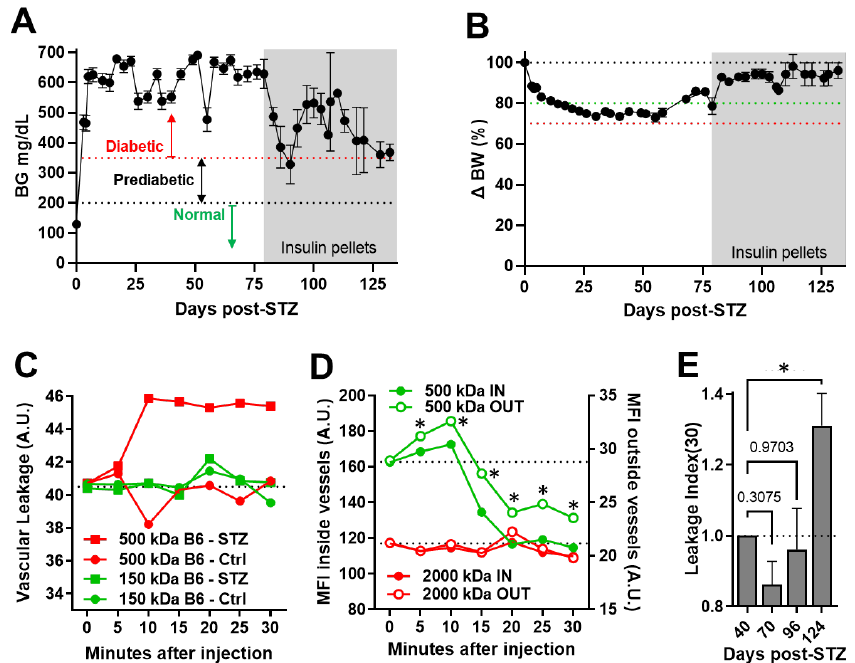
Figure 2. Longitudinal in vivo quantitation of retinal vascular leakage during the progression of induced DR in diabetic C57BL/6 mice. ( A ) Blood glucose levels in streptozotocin (STZ)-induced diabetic C57BL/6 mice showing chronic severe hyperglycemia, which leads to diabetic retinopathy (DR) in 4 months following diabetes induction. ( B ) Body weight changes (expressed as % delta; Δ) following diabetes induction before and during insulin therapy by slow-release insulin pellets (Linplant; LinShin Canada Inc; Toronto, Canada). Data are shown as means ± SEM (n = 3–15 mice). The animal numbers decreased overtime due to attrition in association with age and advanced diabetic complications. ( C ) Representative raw mean fluorescence intensity (MFI) measurements expressed in arbitrary units (A.U.) of 150-kDa (Sigma Cat # FD150S) and 500-kDa (Sigma Cat # 52194) dextrans conjugated to FITC and TRITC, respectively, in a STZ-diabetic (STZ) and a non-diabetic control (Ctrl) mouse. Measurements were obtained during 30 min after the injection, and shown are the MFI ratios outside to inside the vessels of the 150-kDa FITC-labeled (green lines) and 500-kDa TRITC-labeled (red lines) dextrans at each time point during the 30 min. Measurements were aligned to the same level at time 0 (immediately before injection) to highlight the dye’s accumulation over time in the EVS as a measure of the leaked dye (i.e., vascular leakage ). ( D ) Representative raw MFI measurements of FITC-labelled 500-kDa (green) and TRITC-labeled 2000-kDa (red) dextrans inside (IN; left Y -axis) and outside (OUT; right Y -axis) retinal blood vessels of a diabetic AKITA mouse (* indicates significant difference between inside and outside with p value < 0.05 by two-tailed paired t-test). ( E ) Leakage Index (30) values obtained longitudinally in the same STZ-diabetic B6 mice at the indicated numbers of days after the STZ treatment. Data are shown as means ± SEM and plotted and analyzed in GraphPad Prism version 9.5.0 for Windows, GraphPad Software, San Diego, California USA, www.graphpad.com ( n = 3–8 mice/time-point). Pairwise comparisons were performed by one-way ANOVA followed by Dunnett’s multiple comparison test of each time point compared to 40 days. Asterisk (*) denotes significance with p < 0.05, and numerical p values are shown when significance was not reached.